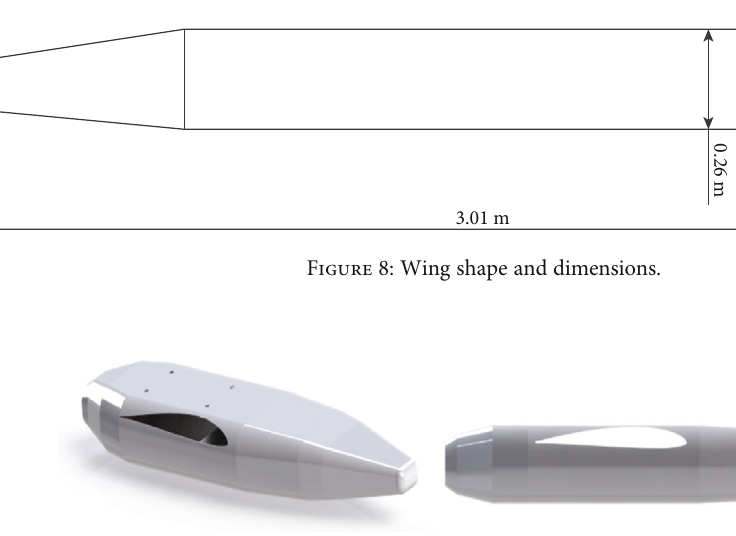
Figure 9: Preliminary design of the fuselage.